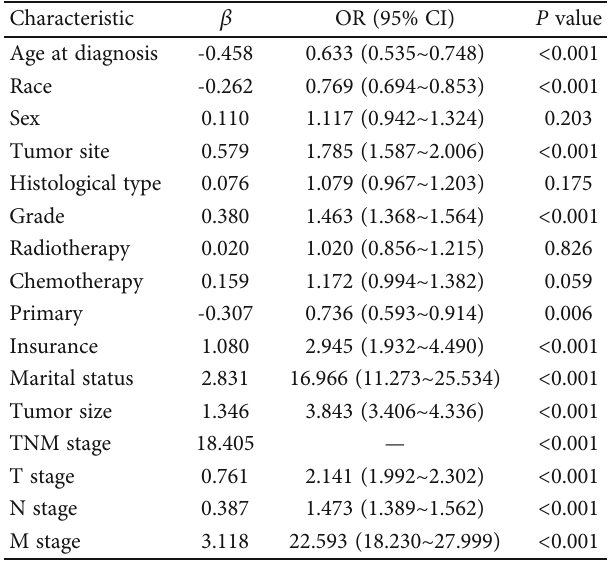
Table 2: Logistic regression analysis of single factor a ff ecting gastric cancer bone metastasis.